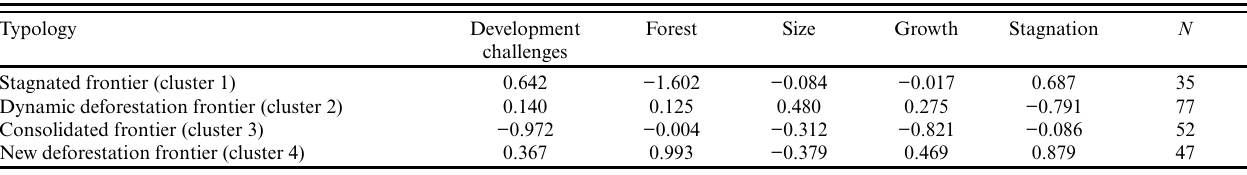
Table 4. Typology of municipalities and cluster results (mean and frequency) based on estimated principal components, 2000–2010. Data sources: INPE (2014), IBGE (2000, 2010), and PNUD (2013).